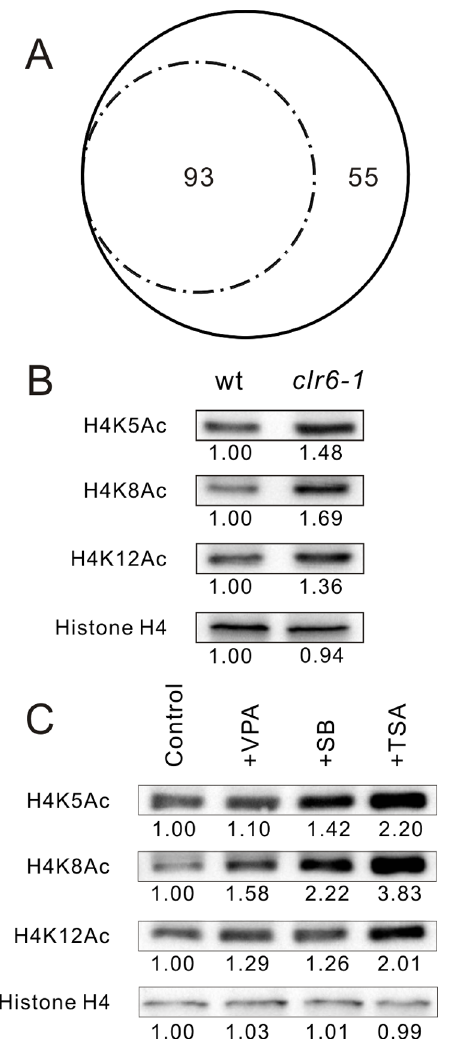
Figure 2. VPA and SB may function as HDAC inhibitor in fission yeast. (A) The Venn diagrams of VPA- or SB- sensitive strains. The SB-